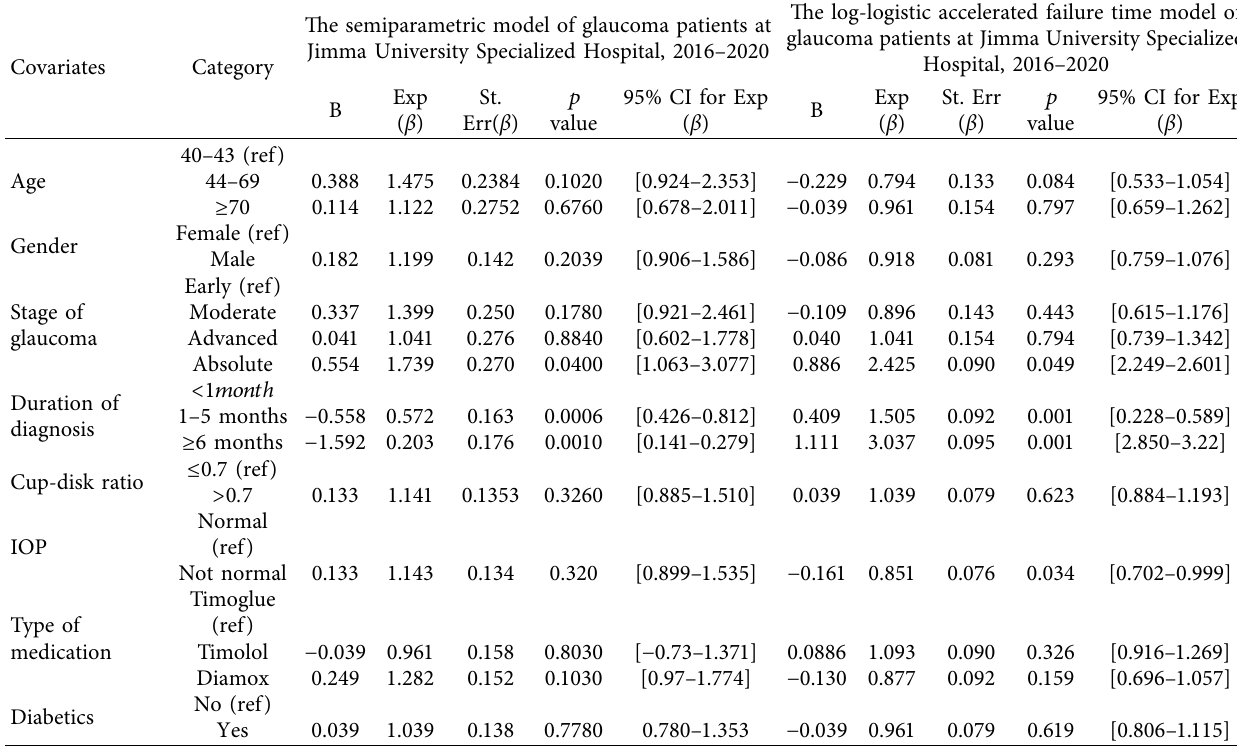
Covariates Category